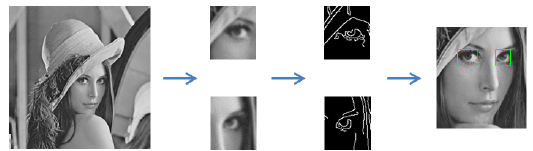
Figure 10: Eye detection process by edges.